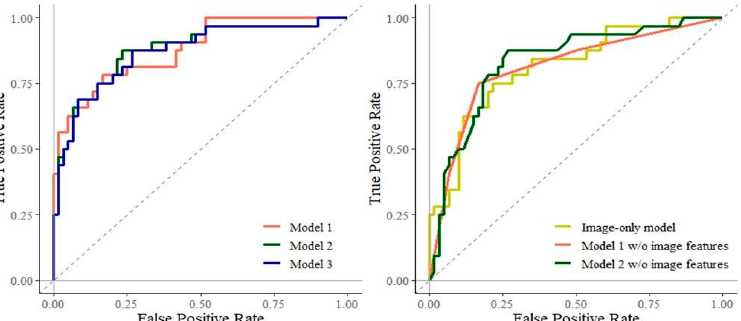
Figure 4. Receiver operating characteristic curves characterizing the screening models. Model 1: sex, categorized BMI, median pixel value, IQR of pixel value, number of feature points. Model 2: age, sex, categorized BMI, median pixel value, IQR of pixel value, number of feature points. Model 3: age, sex, categorized BMI, IQR of pixel value, number of feature points. Image-only model: median pixel value, IQR of pixel value, number of feature points. Abbreviations: BMI, body mass index; IQR, interquartile range; w/o = without.